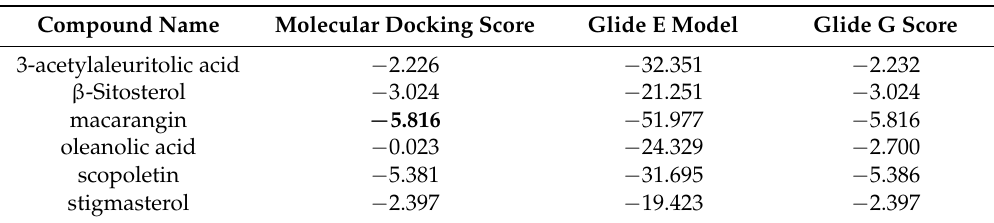
Table 3. Molecular docking score of the phytoconstitiuents isolated from M. denticulata on COX-1 enzyme for antinociceptive activity.